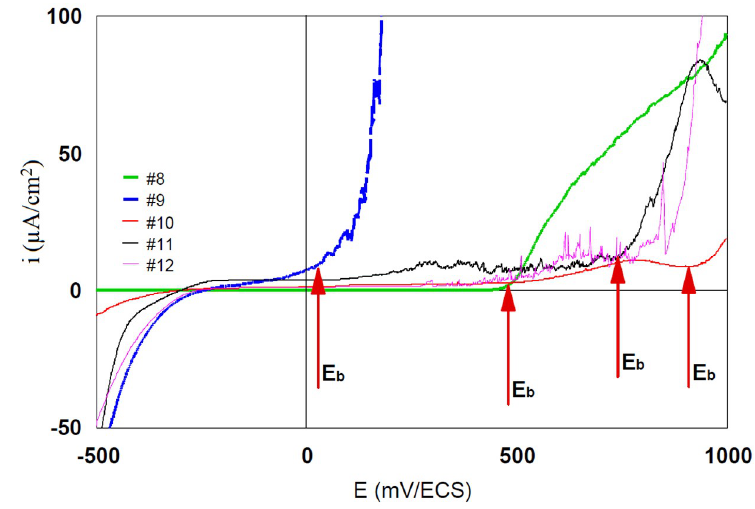
Figure 8. Linear potentiodynamic curves of 316L (#8 and #9) and 904L (#9, #10, and #11) steels, usually